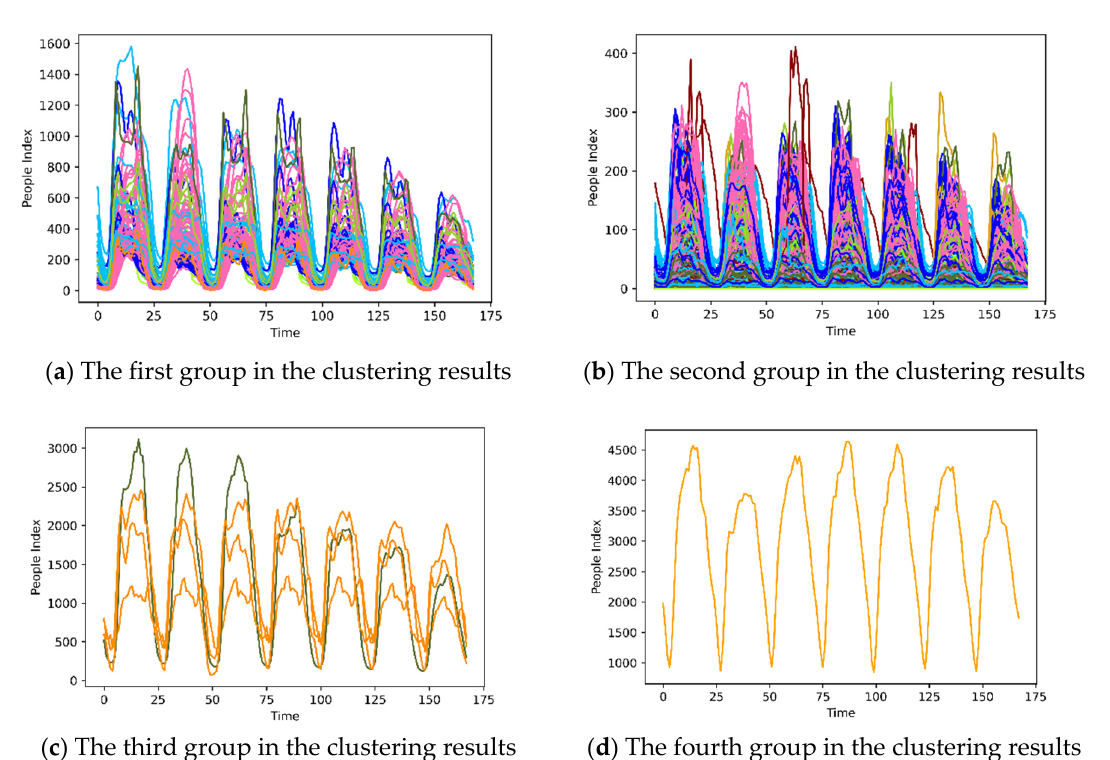
Figure 8. Clustering results of four changing patterns of pedestrian flow in Beijing hotspot locations before the epidemic.